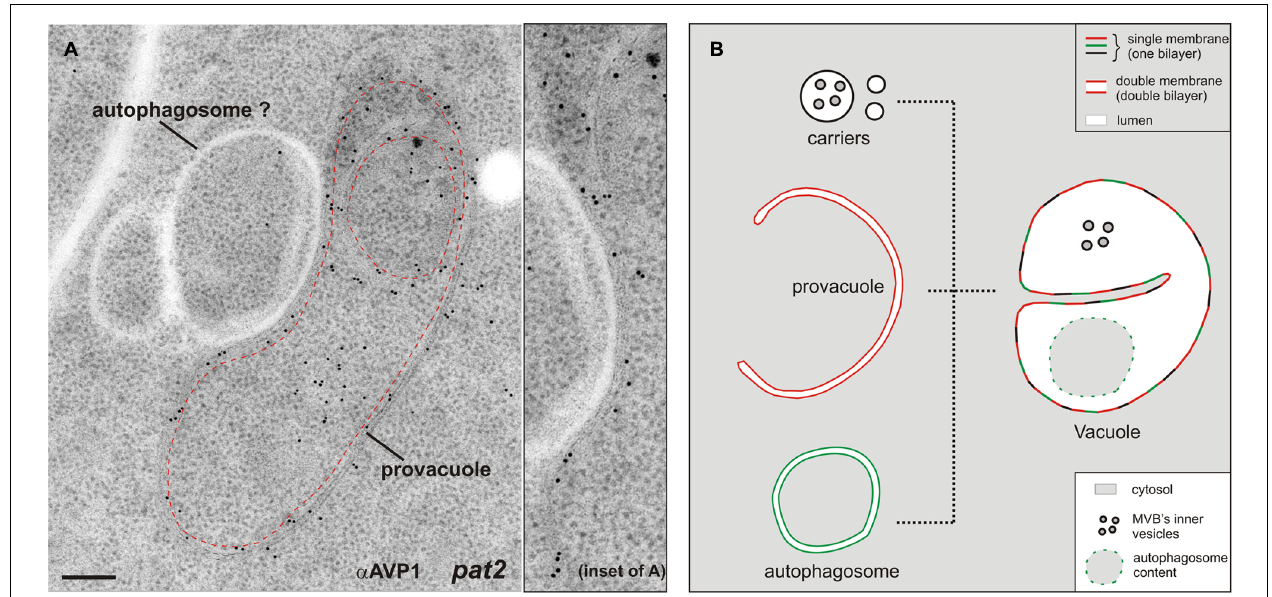
picture shows that at least two distinct populations of circular/semicircular double-bilayered structures existin Arabidopsis root-tip cells. Scale bar, 200 nm. (B) The development of mature vacuoles is probably the result of fusion events between provacuoles, autophagosomes and vacuolar transport